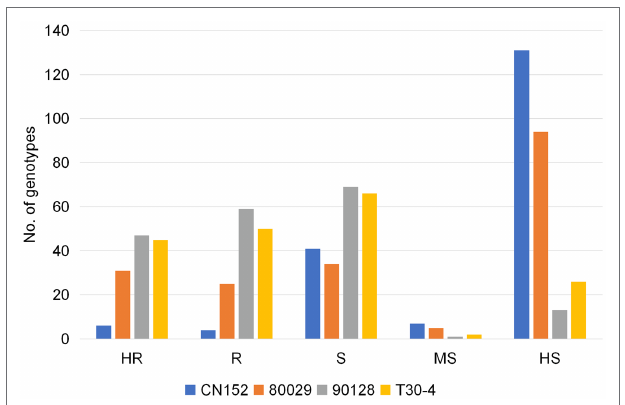
FIGURE 2 | The resistance distribution of 189 potato genotypes in response to four P. infestans isolates. Phenotype: highly resistant (HR); resistant (R); sensitive (S); moderately sensitive (MS); and highly sensitive